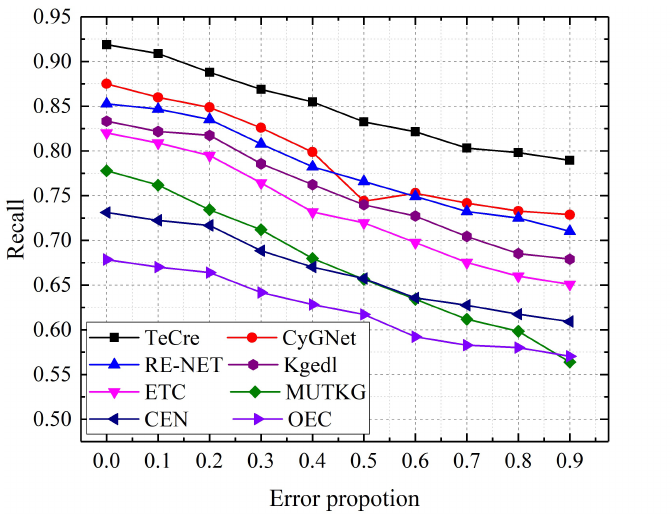
Figure 10. Recall on ICEWS’14 with different error